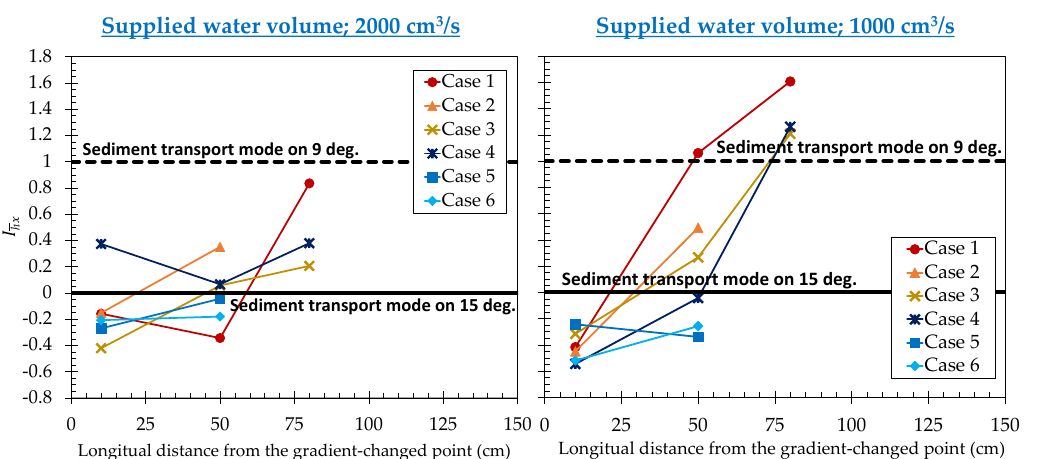
Figure 5. Transition indices of sediment transport modes based on flow depths of the “frontal part” of the debris flow, 𝐼 ℎ̅𝑥 , for all cases with two inflow rates.